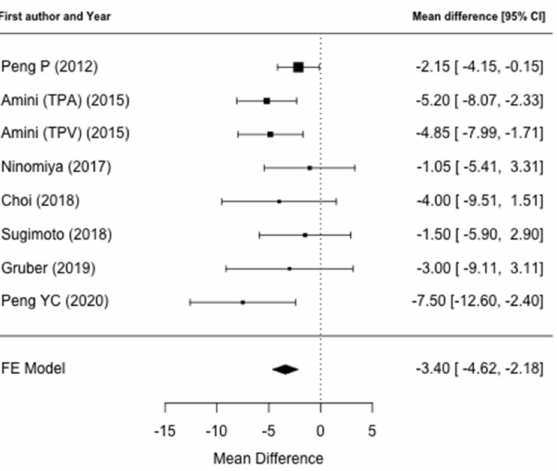
Figure 8. Forrest plot for the mean difference of overall survival. The mean survival loss for patients with low muscle mass was 3.4 months.